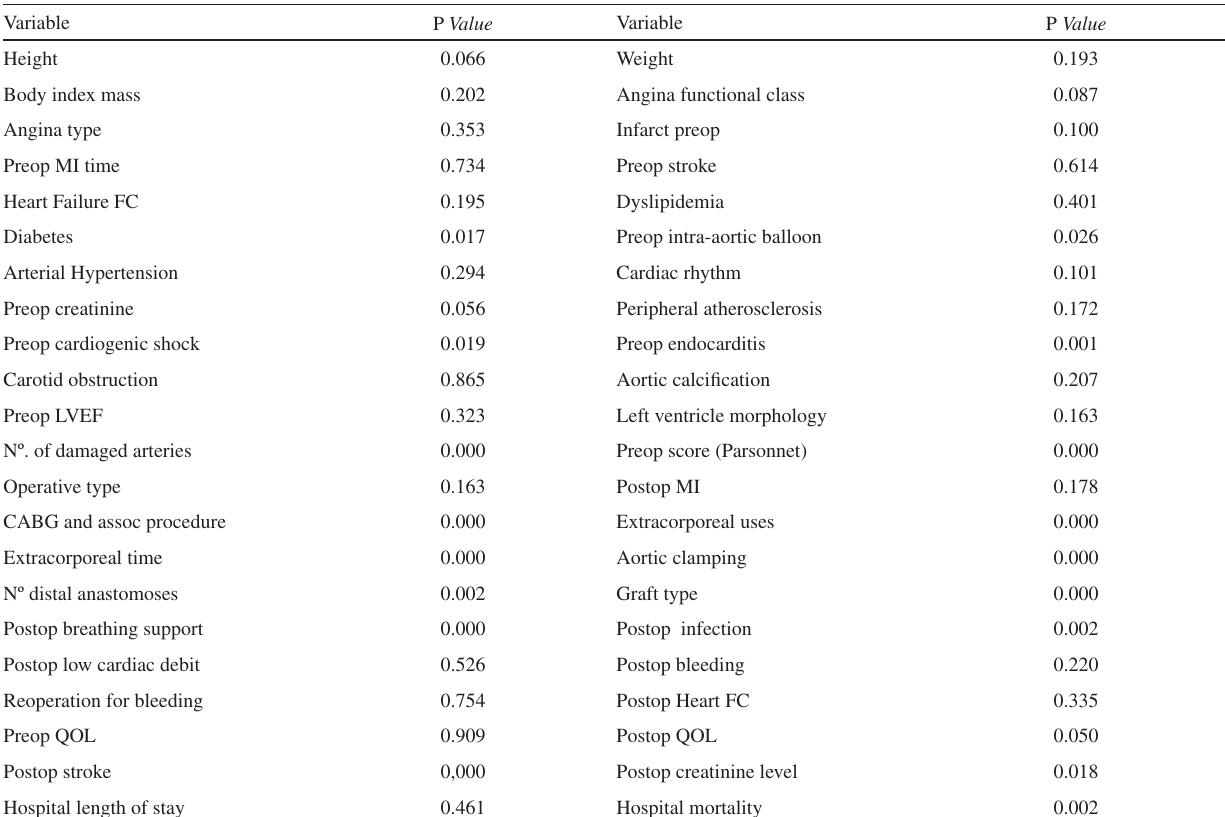
Table 2 - Univariate analysis of study